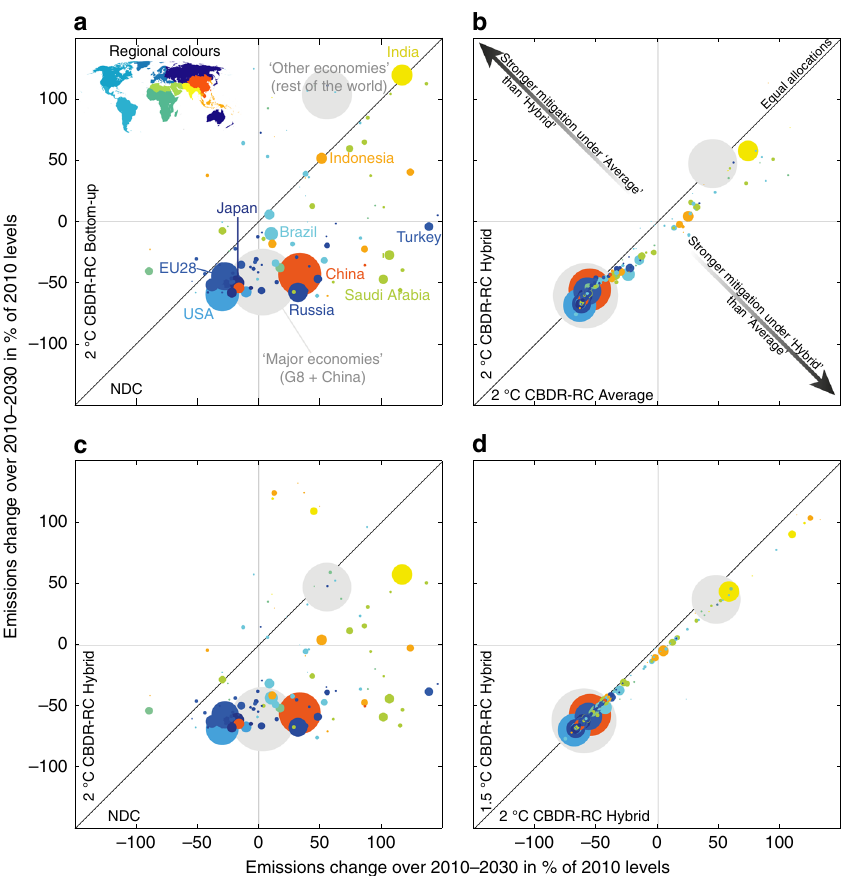
Fig. 3 Comparison of emissions changes over 2010-2030 across diverse combinations of equity and with NDCs. The CBDR-RC hybrid setup combines three equity principles: equality, responsibility and capability. a Comparison of the CBDR-RC bottom-up allocation of the 2 °C-scenario and countries NDCs. b Comparison of the CBDR-RC hybrid allocation and the average of the three equity allocations, under the 2 °C-scenario. c Comparison of the CBDR-RC hybrid allocation of the 2 °C-scenario and countries ’ NDCs. d Comparison of the CBDR-RC hybrid allocation of the 2 °C-scenario and 1.5 °C- scenario. Discs ’ sizes are proportional to 2010-emissions level. Colours indicate countries ’ world regions, and the major economies (G8 + China, larger disk) and the other economies (all countries other than G8 countries and China, smaller disk) are shown in grey. The NDC evaluation follows the average evaluation of ref.